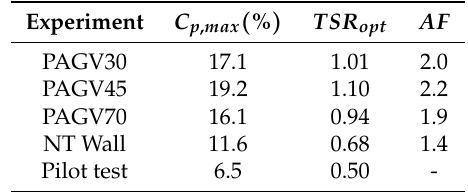
Table 2. Optimum C p , and corresponding TSR , AF and power increment for the Savonius turbine in the wind tunnel for the pilot text, negative torque vertical wall, and different angles of the vane.